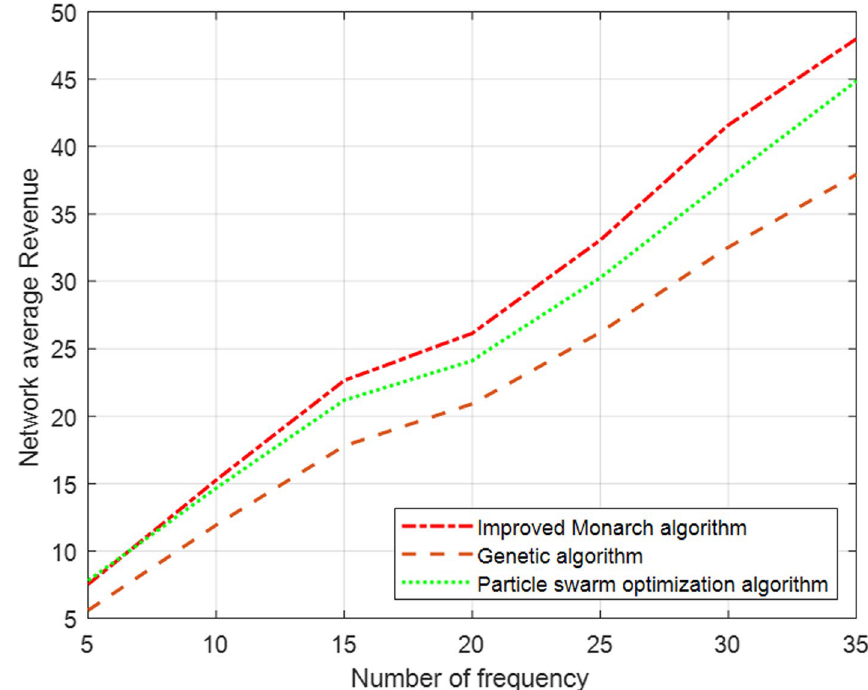
Fig. 10 Average income transformation of the network, when T